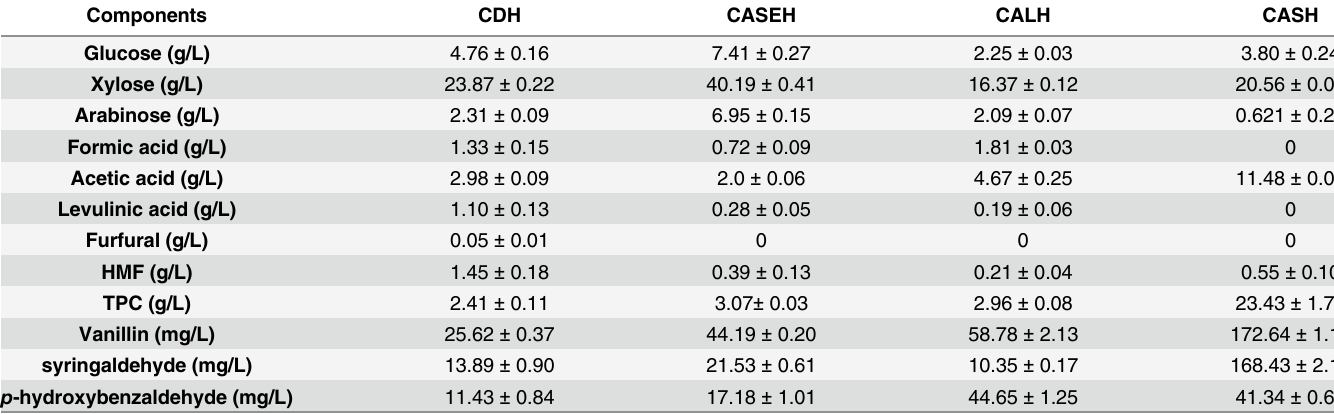
Table 1. Major composition of condensed dilute-acid hydrolysate (CDH), condensed acid-catalyzed steam-exploded hydrolysate (CASEH), acid- catalyzed liquid hot water hydrolysate (CALH) and condensed acid-catalyzed sulfite hydrolysate